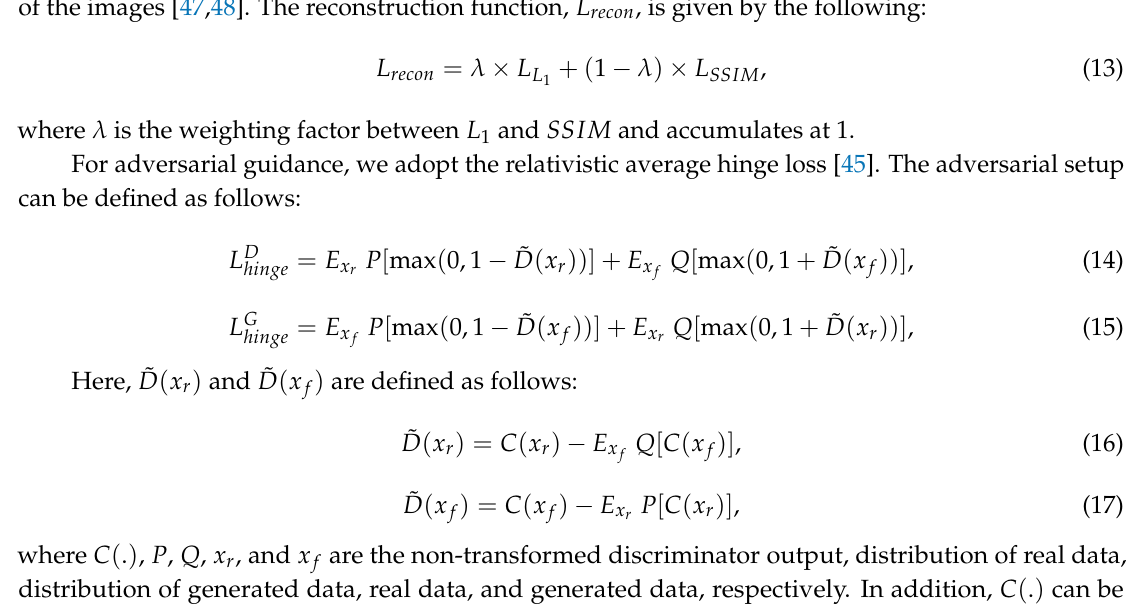
Figure 5. The discriminator calculates the probabilities whether the features in the generated feature volume are real or fake, with respect to the features in the ground truth feature volume. Using the CNN-based discriminator, the receptive fields of each point in the output map can cover the input image, as shown in Figure 5. A dropout layer is incorporated in the discriminator to allow stochasticity in the